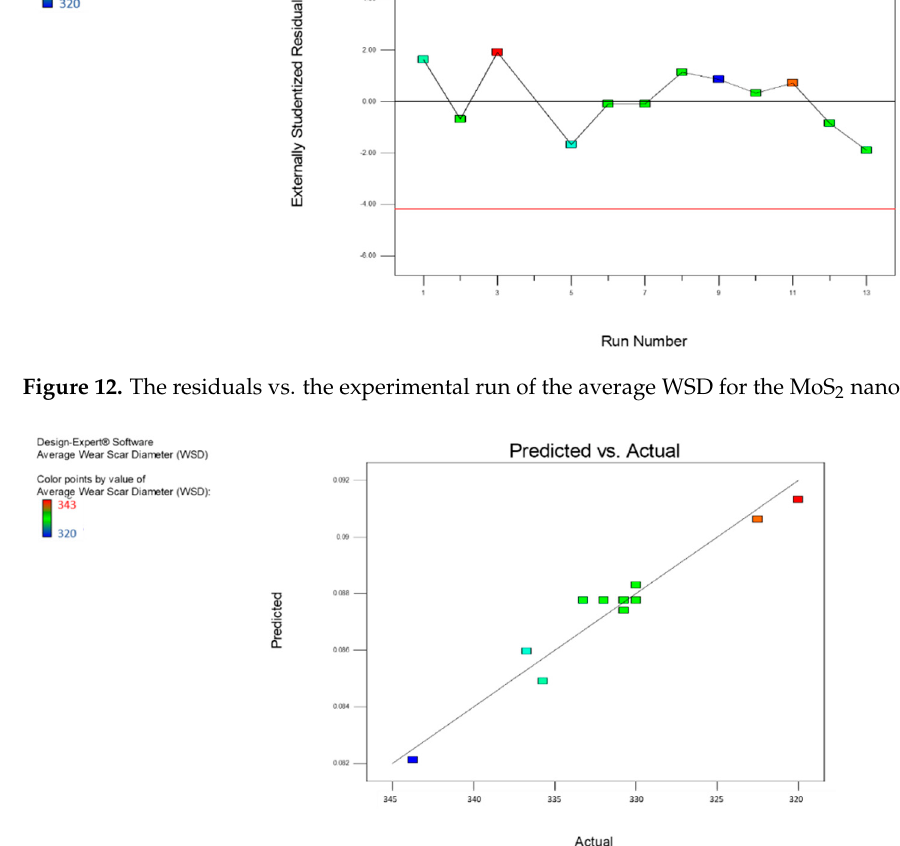
Figure 13. The residuals vs. the experimental run of the average WSD for the MoS 2 nanolubricants.